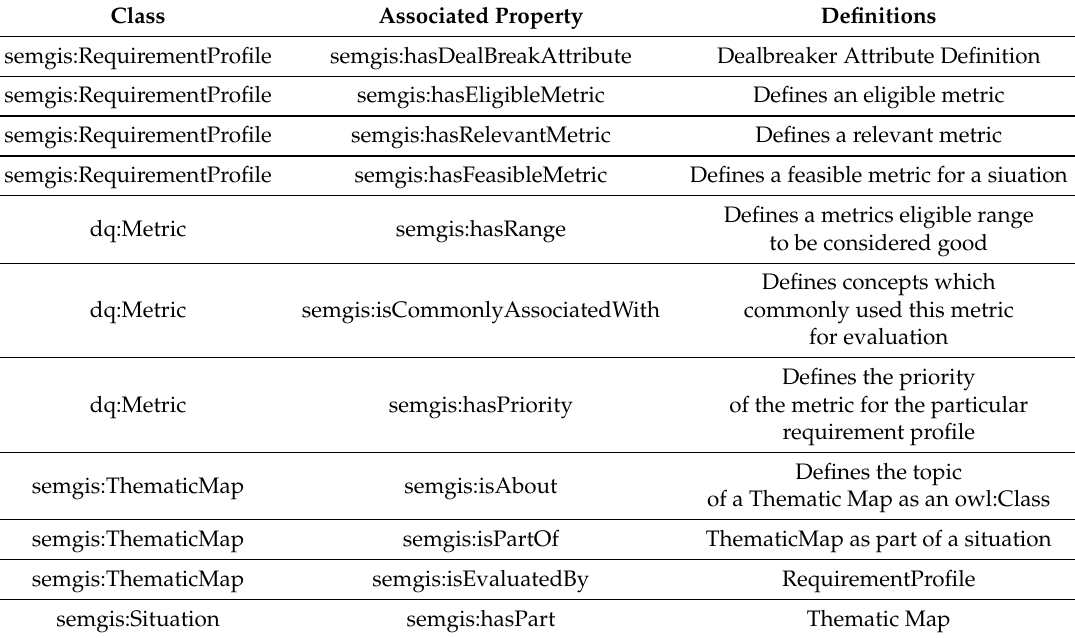
Table 2. Vocabulary Definitions for situations: Properties associated to the respective classes as indicated in the table. The relevance of the respective properties will be discussed in the following sections. Class Associated